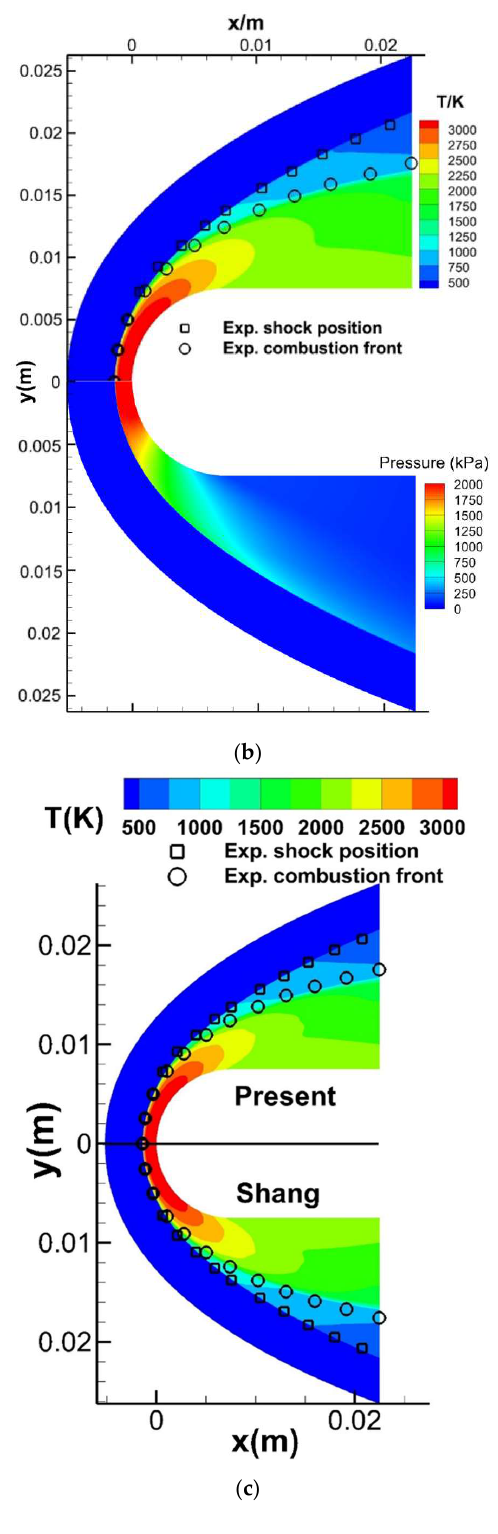
Figure 16. Comparison of the super-detonative combustion flow fields. ( a ) Density gradient distri- bution compared with the schlieren image. ( b ) Pressure and temperature distribution of the hybrid kinetic scheme. ( c ) Bow shock wave and combustion front of the numerical results. The distributions of the pressure, temperature, density, and mass fraction of the species along the stagnation line are also compared with the result of the Shang scheme